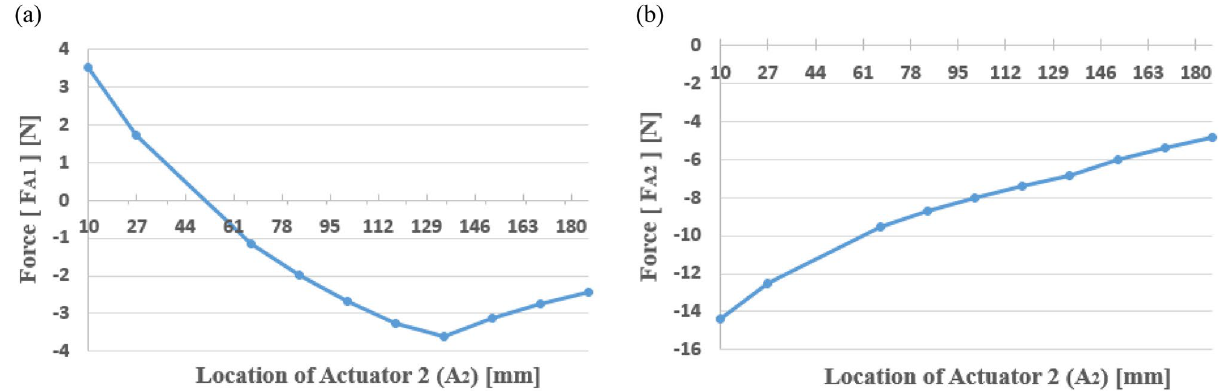
Figure 11. Actuator force of each path according to the location of actuator 2 (A2): ( a ) path 1; ( b ) path 2.